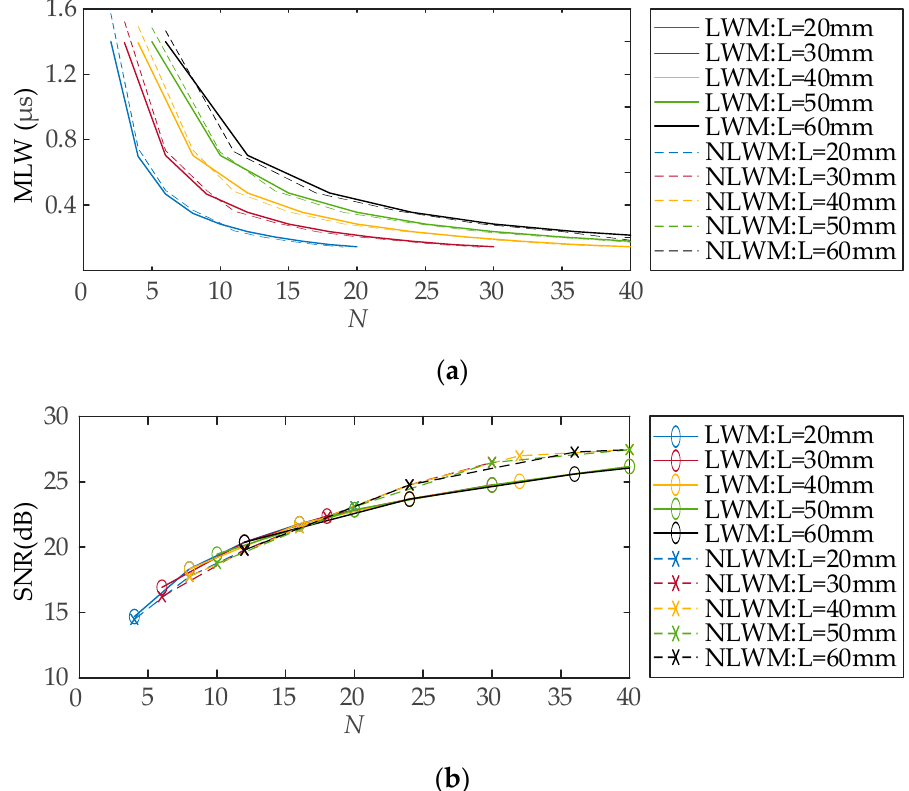
Figure 7. The effect of the conductor number on pulse compression performance: ( a ) MLW; ( b ) SNR.